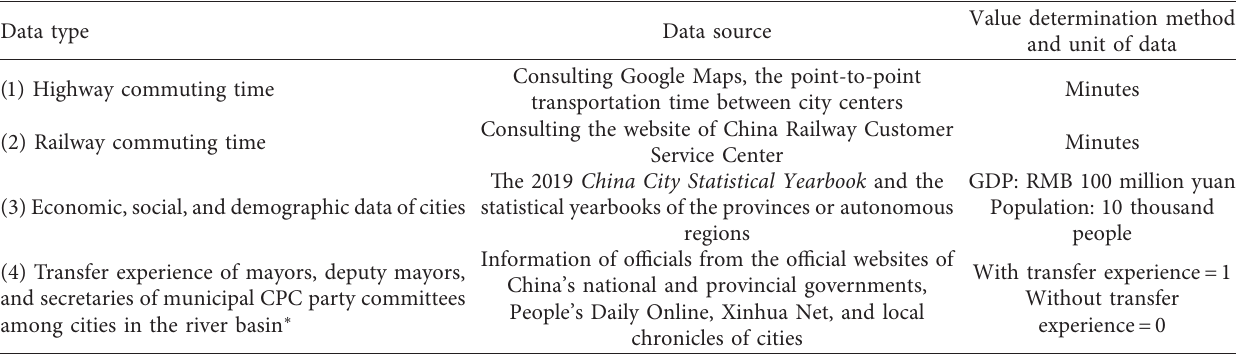
Table 1: Main sources of data studied in this paper.